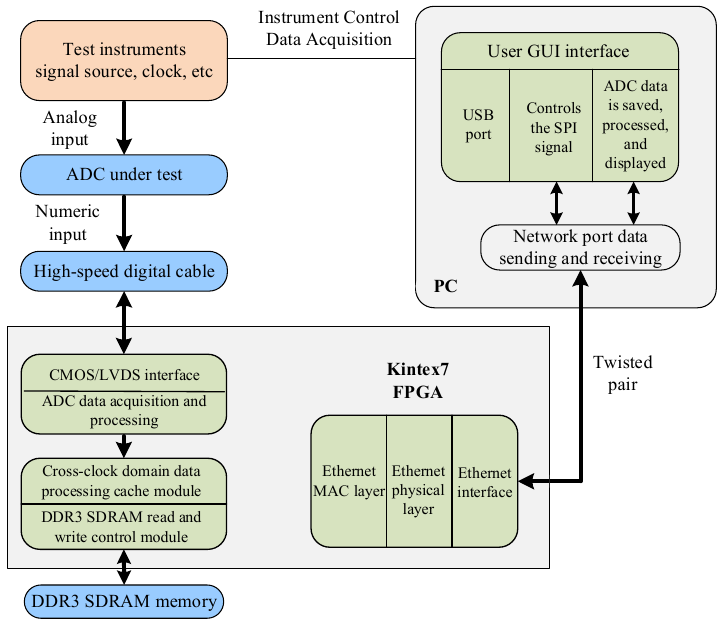
Figure 7. Overall scheme of the ADC spectrum testing setup.